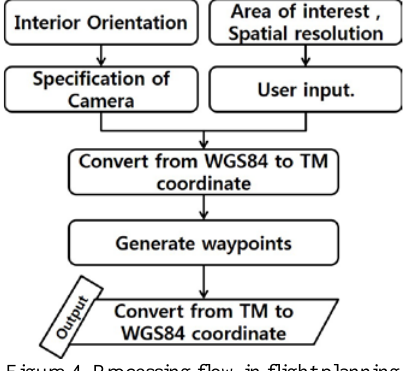
Figure 4. Processing flow in flight planning